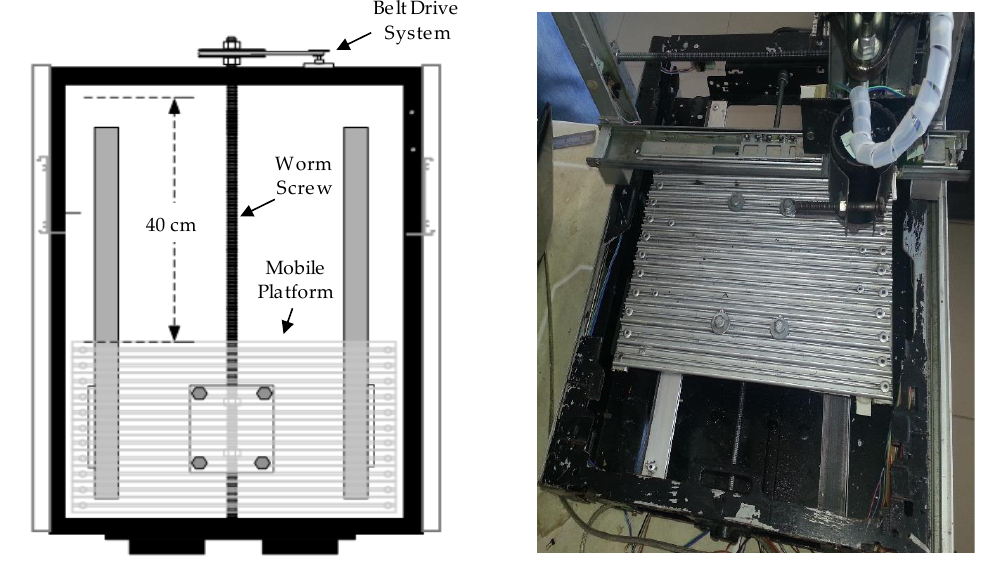
Figure 4. Mechanical system of the Y axis.